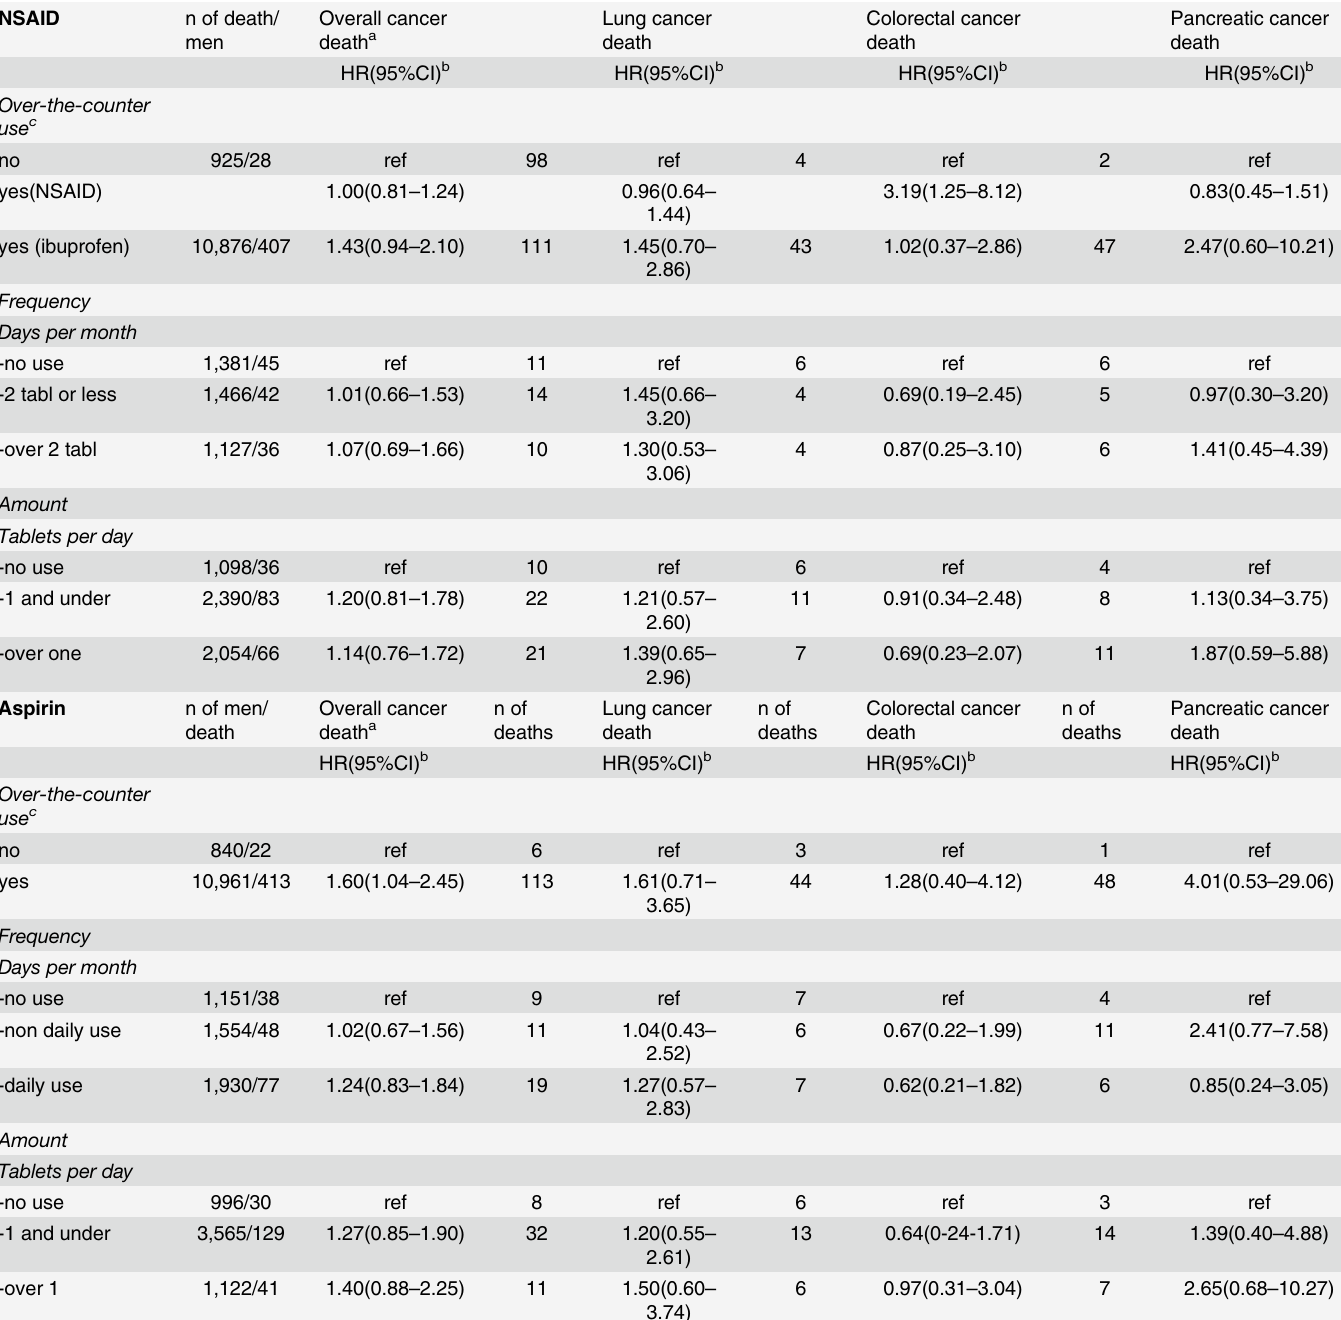
Table 2. Over-the-counter NSAID use and cancer mortality by amount and frequency of use in the Finnish Prostate Cancer Screening Trial during 1996 – 2012. NSAID n of death/